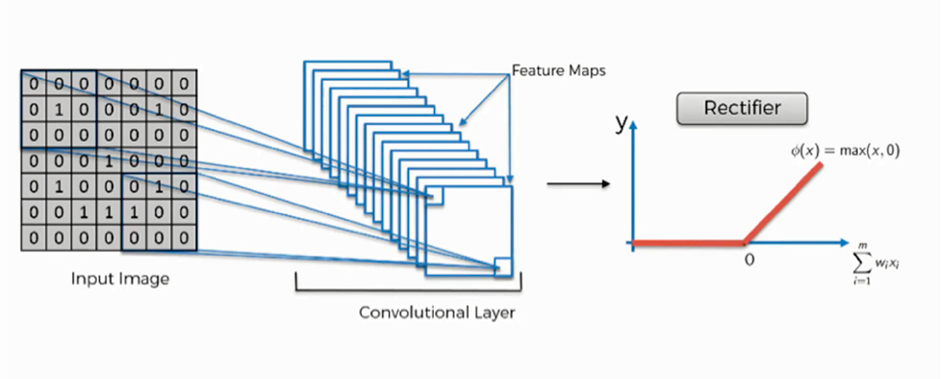
Figure 15. Rectifier functions [57].